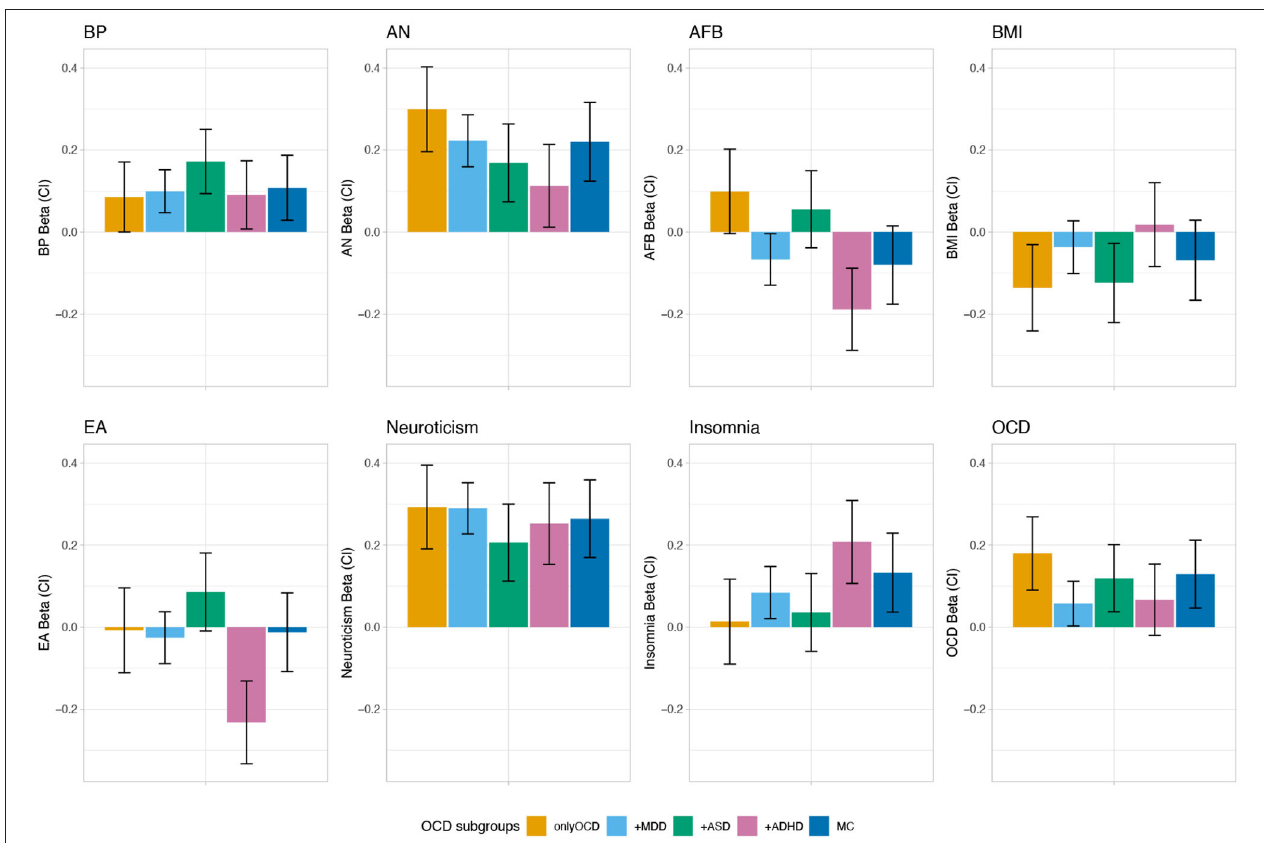
FIGURE 3 | PRS profile across distinct comorbid OCD subgroups in the iPSYCH sample. The bars show coefficients from multivariate multivariable regression of the eight normalized PRS over OCD subgroups, adjusting for the first four PCs and for 23 waves, whiskers indicate 95% confidence intervals (CI). Results are shown for eight different phenotypes: bipolar disorder (BP) ( Stahl et al., 2019), anorexia nervosa (AN) (Watson et al., 2019), age at first birth (AFB) (Barban et al., 2016), body mass index (BMI) ( Yengo et al., 2018), educational attainment (EA) (Lee et al., 2018), neuroticism (Nagel et al., 2018), obsessive-compulsive disorder (OCD) (International Obsessive Compulsive Disorder Foundation Genetics, 2017), and insomnia (Jansen et al.,